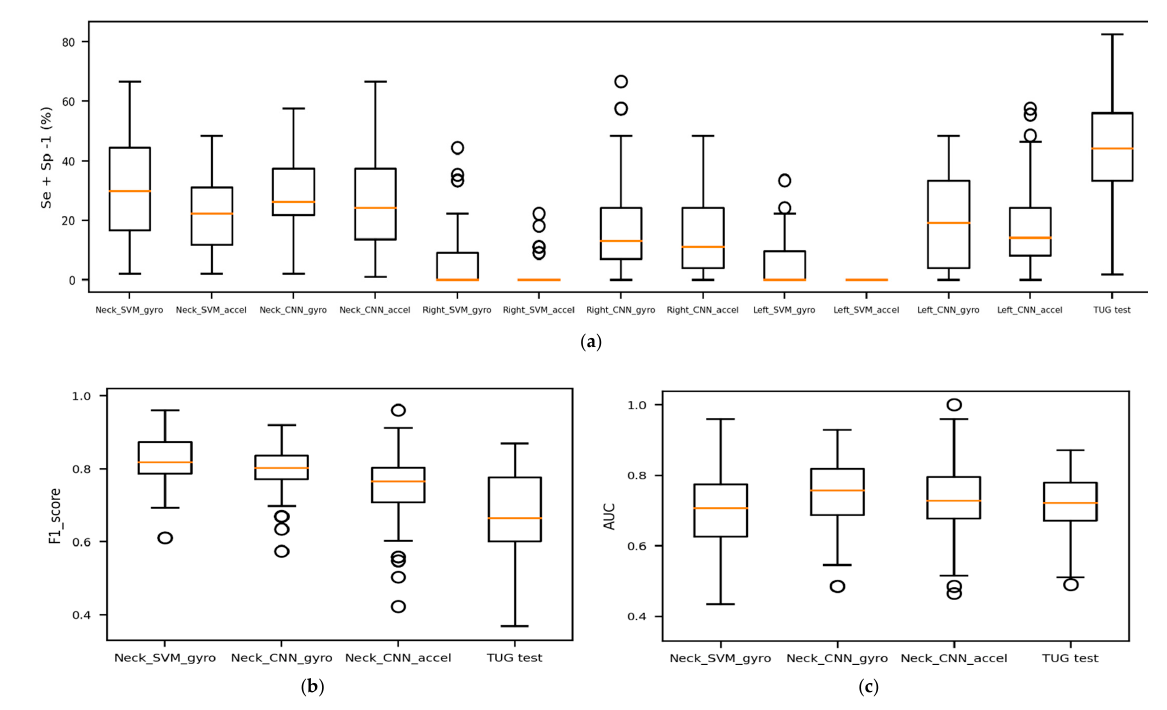
Figure 4. Comparison of models’ prediction performance. ( a ) represents the models’ trade-off between sensitivity and specificity; ( b ) compares the best models’ F1-score with the traditional TUG; ( c ) illustrates the overall power of faller/non- faller discrimination for the best models and the traditional TUG.